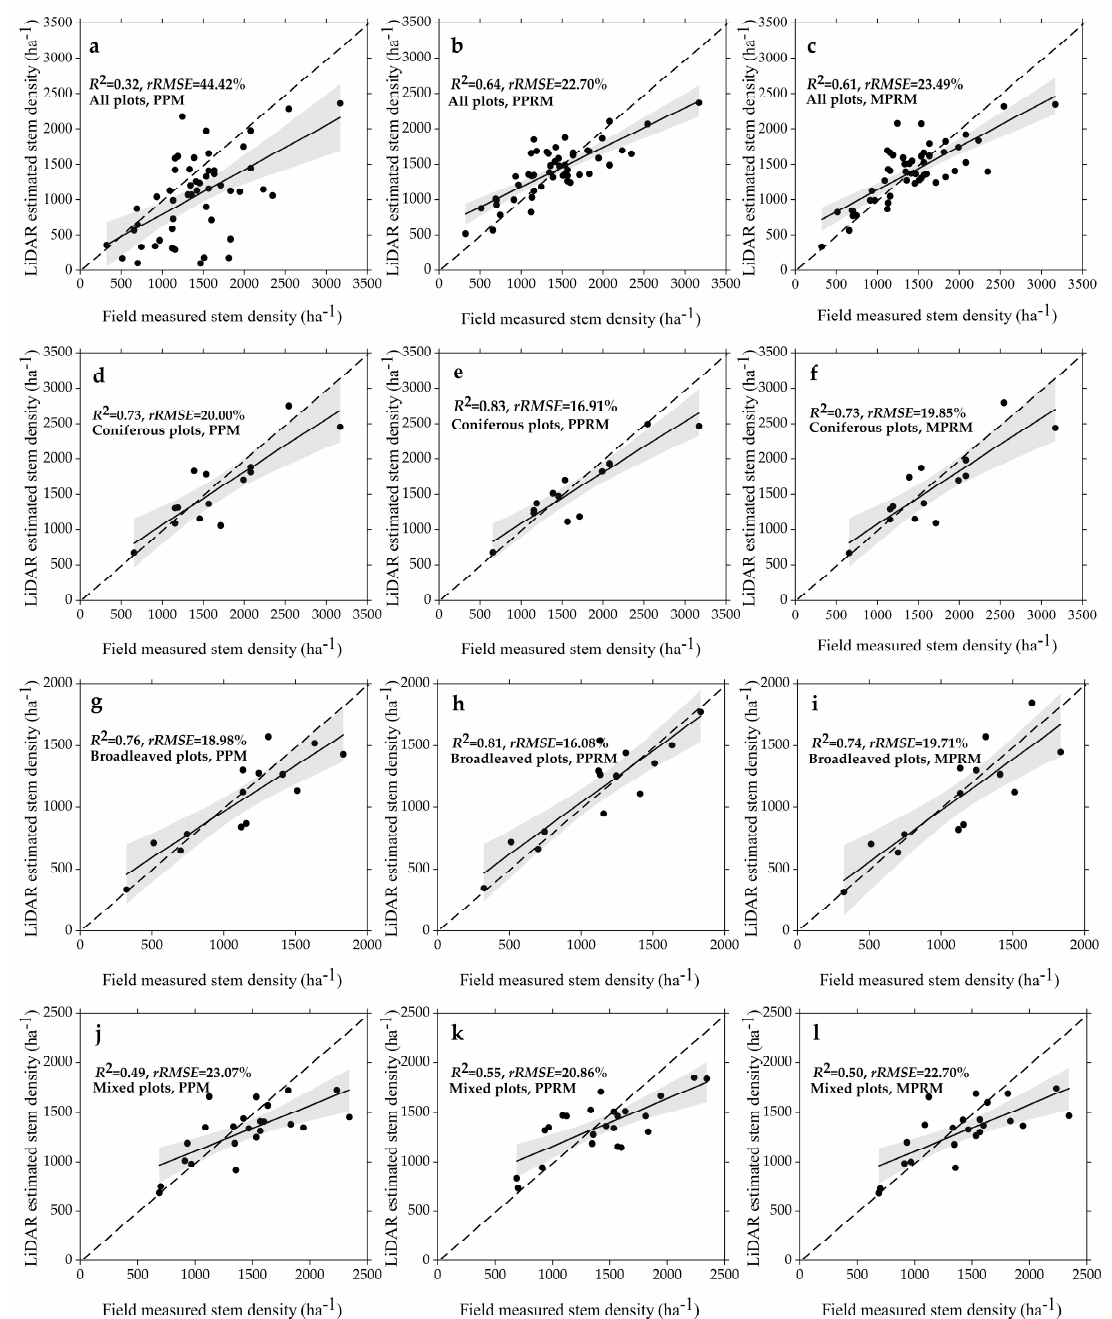
Figure 3. Field-measured stem density versus LiDAR-estimated stem density based on the prediction methods of PPM (left panel), PPRM (middle panel), and MPRM (right panel) in all forest plots ( a – c ), coniferous forests ( d – f ), broadleaved forests ( g – i ), and mixed forests ( j – l ). Light grey shade represents the 95% confidence interval for predictions. PPM: parameter prediction method; PPRM: percentile-based parameter recovery method; MPRM: moment-based parameter recovery method.